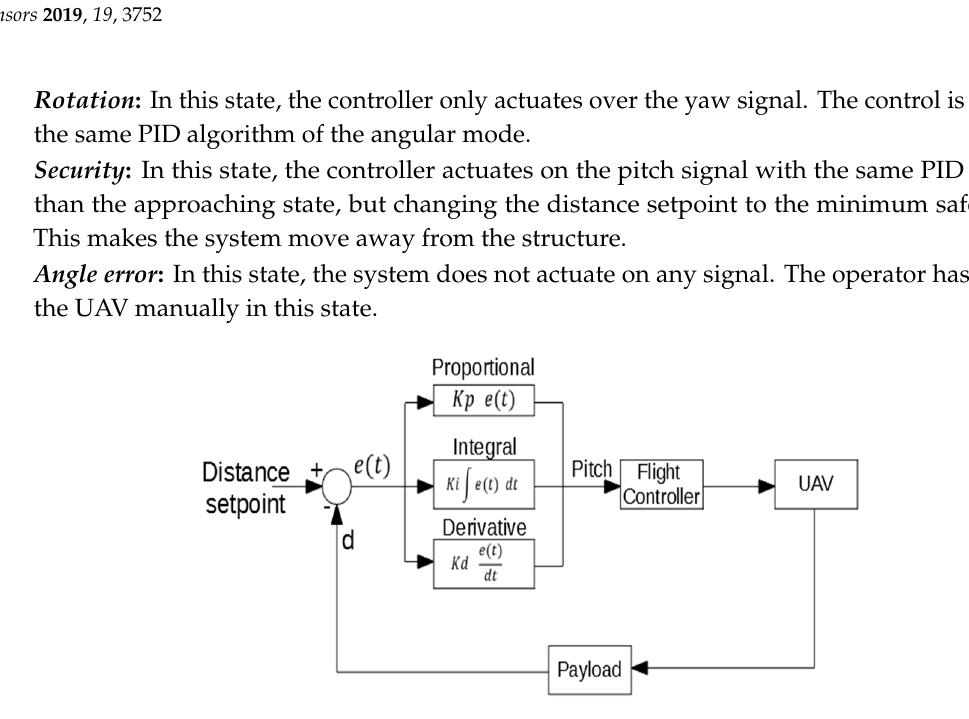
Figure 10. PID algorithm for the approaching control.